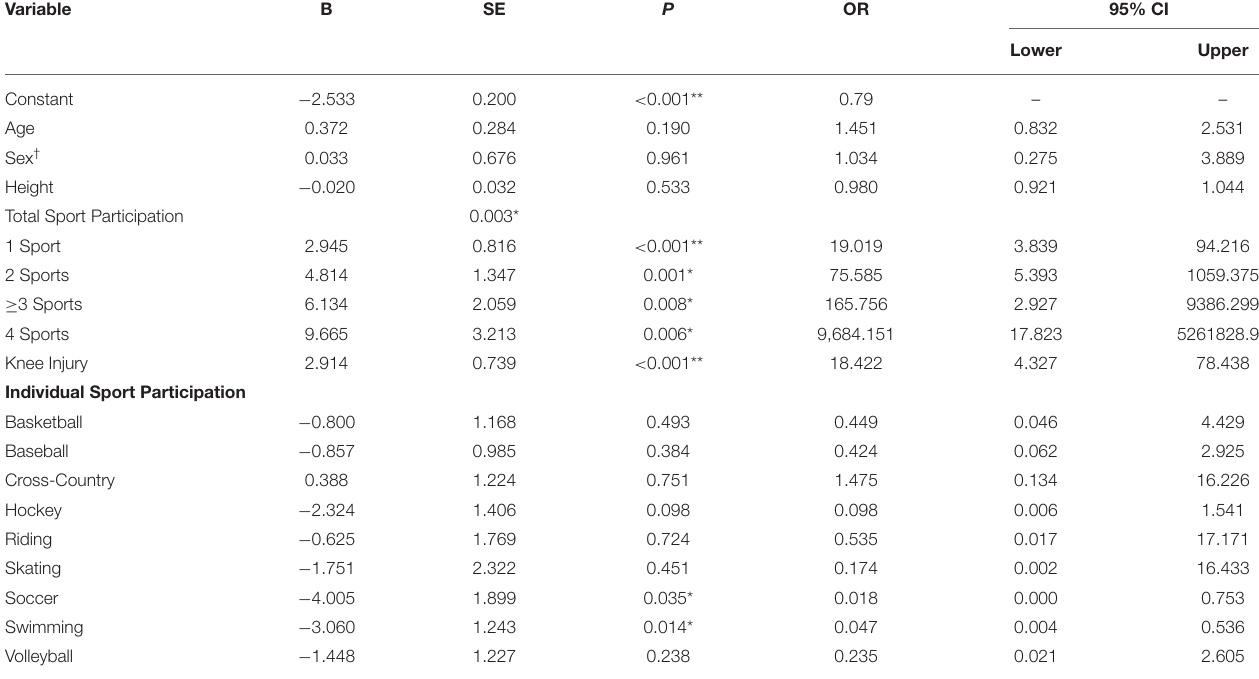
( Table 3 ). Two sports were significant in the model, participation